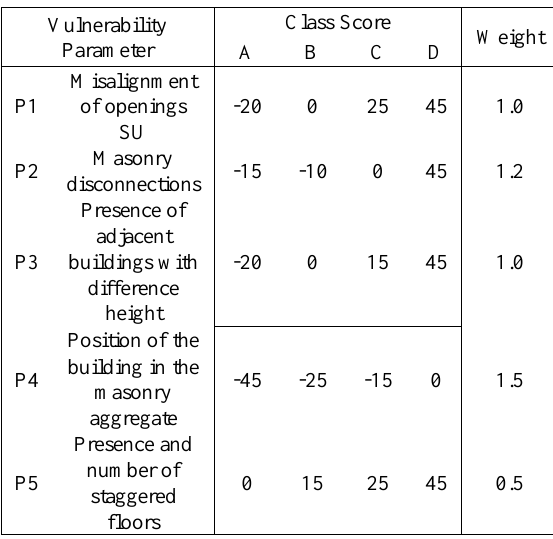
Table 4. Additional parameters of the Formisano method.